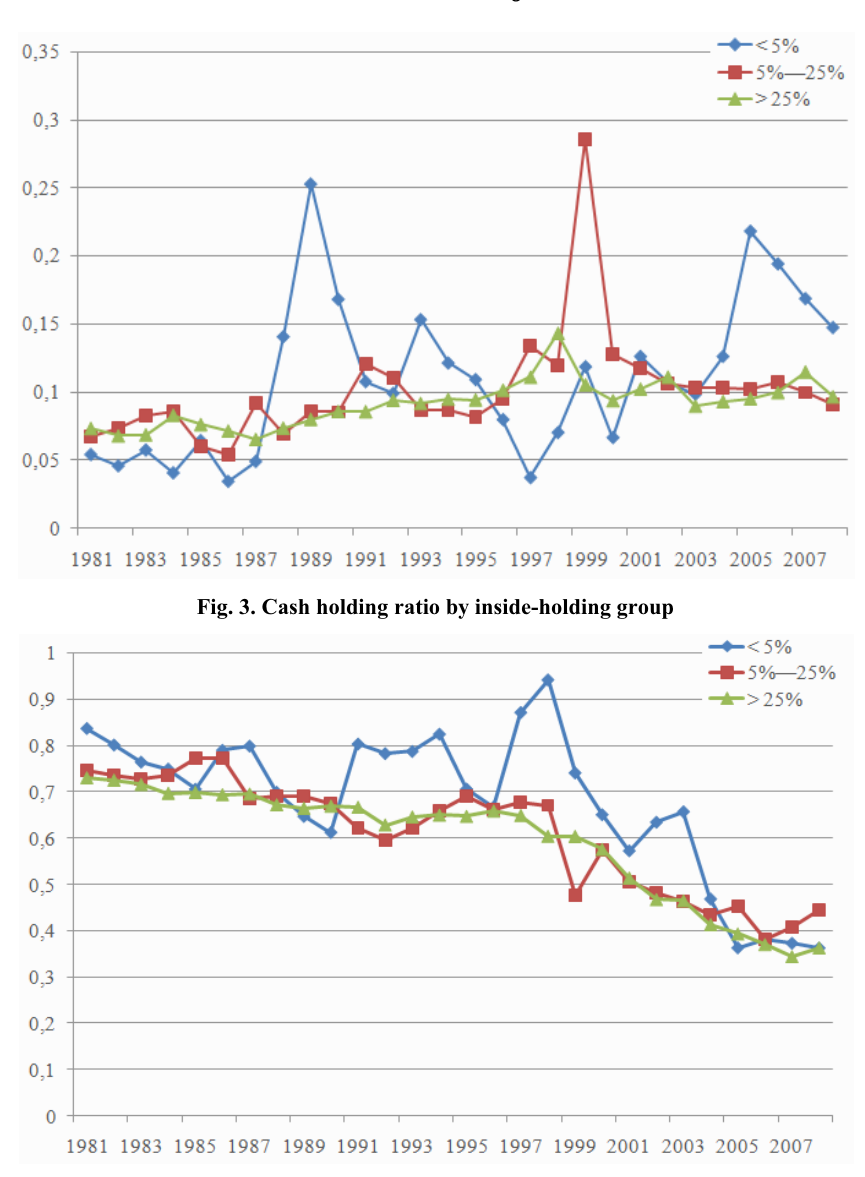
Fig. 4. Net leverage ratio by inside-holding